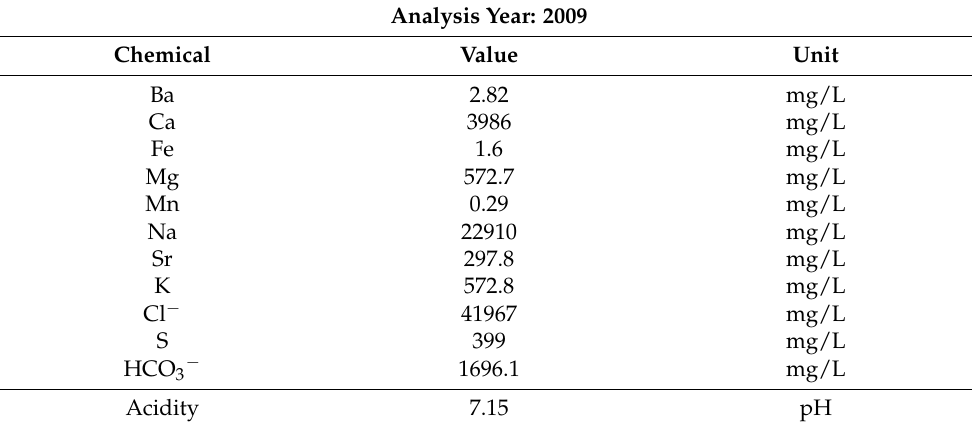
Table 4. Chemical analysis of the fluid in well